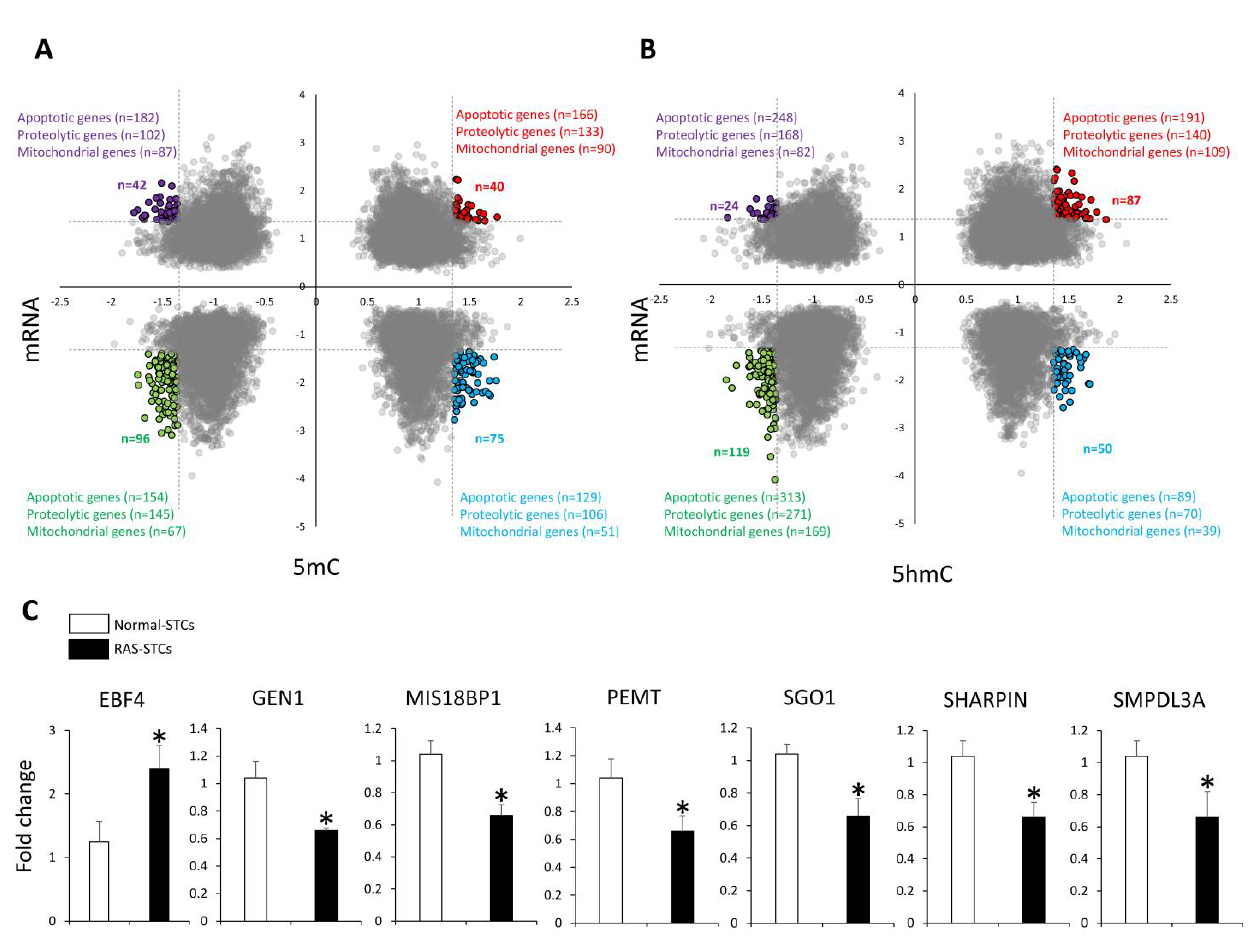
Figure 4. RAS-induced 5mC and 5hmC marks correlate with changes in gene expression in swine STCs. ( A ) Scatter plots of gene sets with significant overlap (5mC levels and mRNA expression) between Nor- mal- and RAS-STCs, containing apoptotic, proteolytic, and mitochondrial genes. ( B ) Scatter plot of gene sets with significant overlap (5hmC levels and mRNA expression) between Normal- and RAS-STCs, con- taining apoptotic, proteolytic, and mitochondrial genes. ( C ) Expression (qPCR) of randomly selected genes dysregulated in RAS- versus Normal-STCs followed the same patterns as the mRNA-seq findings. * p < 0.05 vs. Normal-STCs.